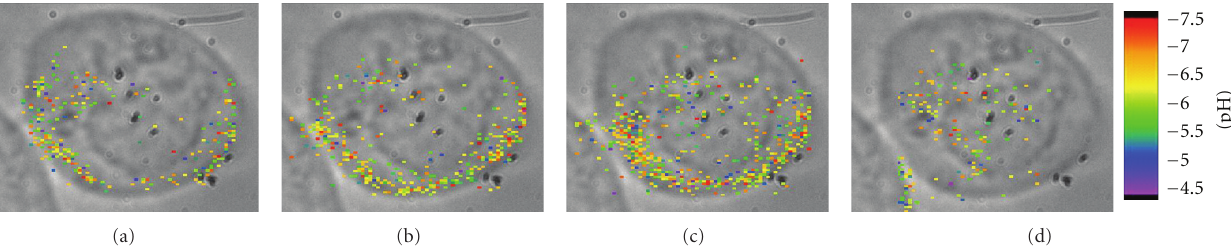
Figure 5: Time-lapse pH-calibrated images acquired every 3.5min upon nanosensor addition up to 90 min. Calibrated pixels demonstrating pH are overlaid with bright field images. (a) 28 minutes, (b) 45.5 minutes, (c) 59.5 minutes and (d) 80.5 minutes. Reprinted with permission from Nowak-Lovato et al. [11] (copyright 2009 Society for Applied